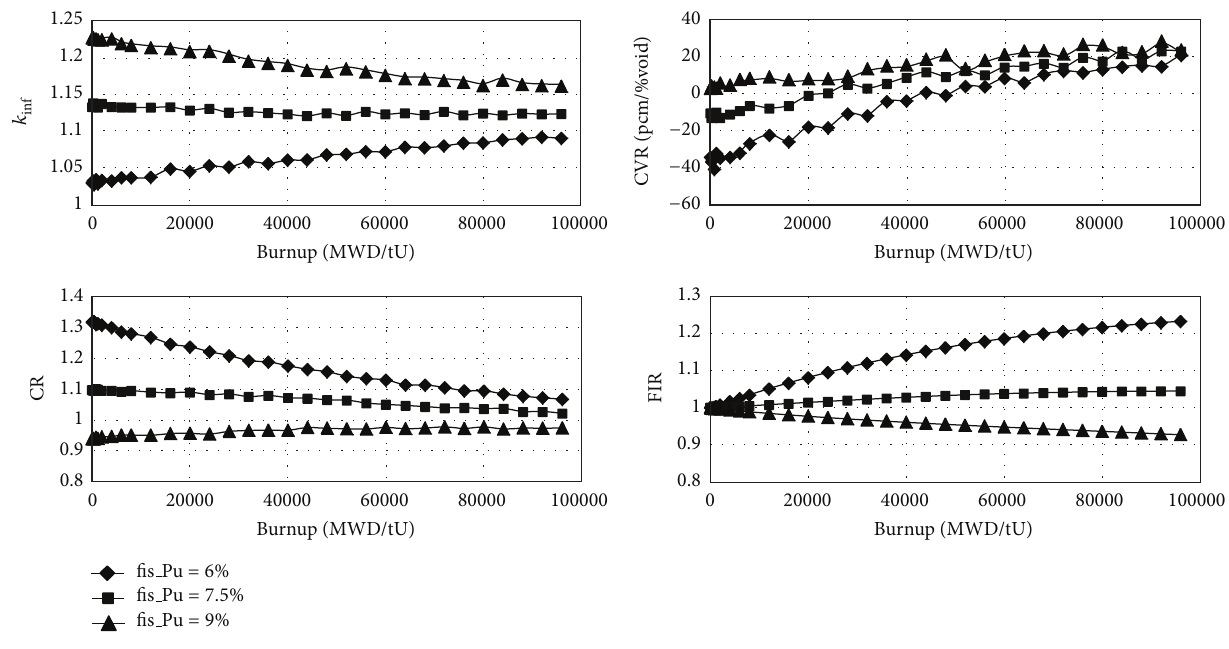
Figure 6: Inner cell burnup performances with DU-MOX fuel.